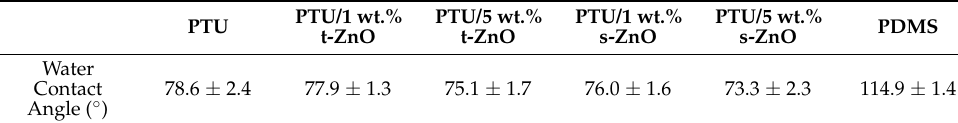
Table 3. Water contact angle measurements of polymer